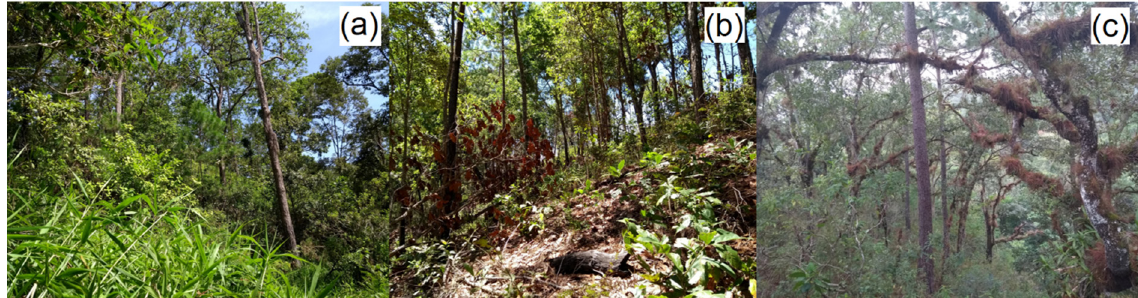
Figure 3. Profile view of the silvicultural treatments in the Ocotones forest, Chiapas, Mexico: ( a ) Liberation cut, ( b ) Thinning II, and ( c ) No treatment.